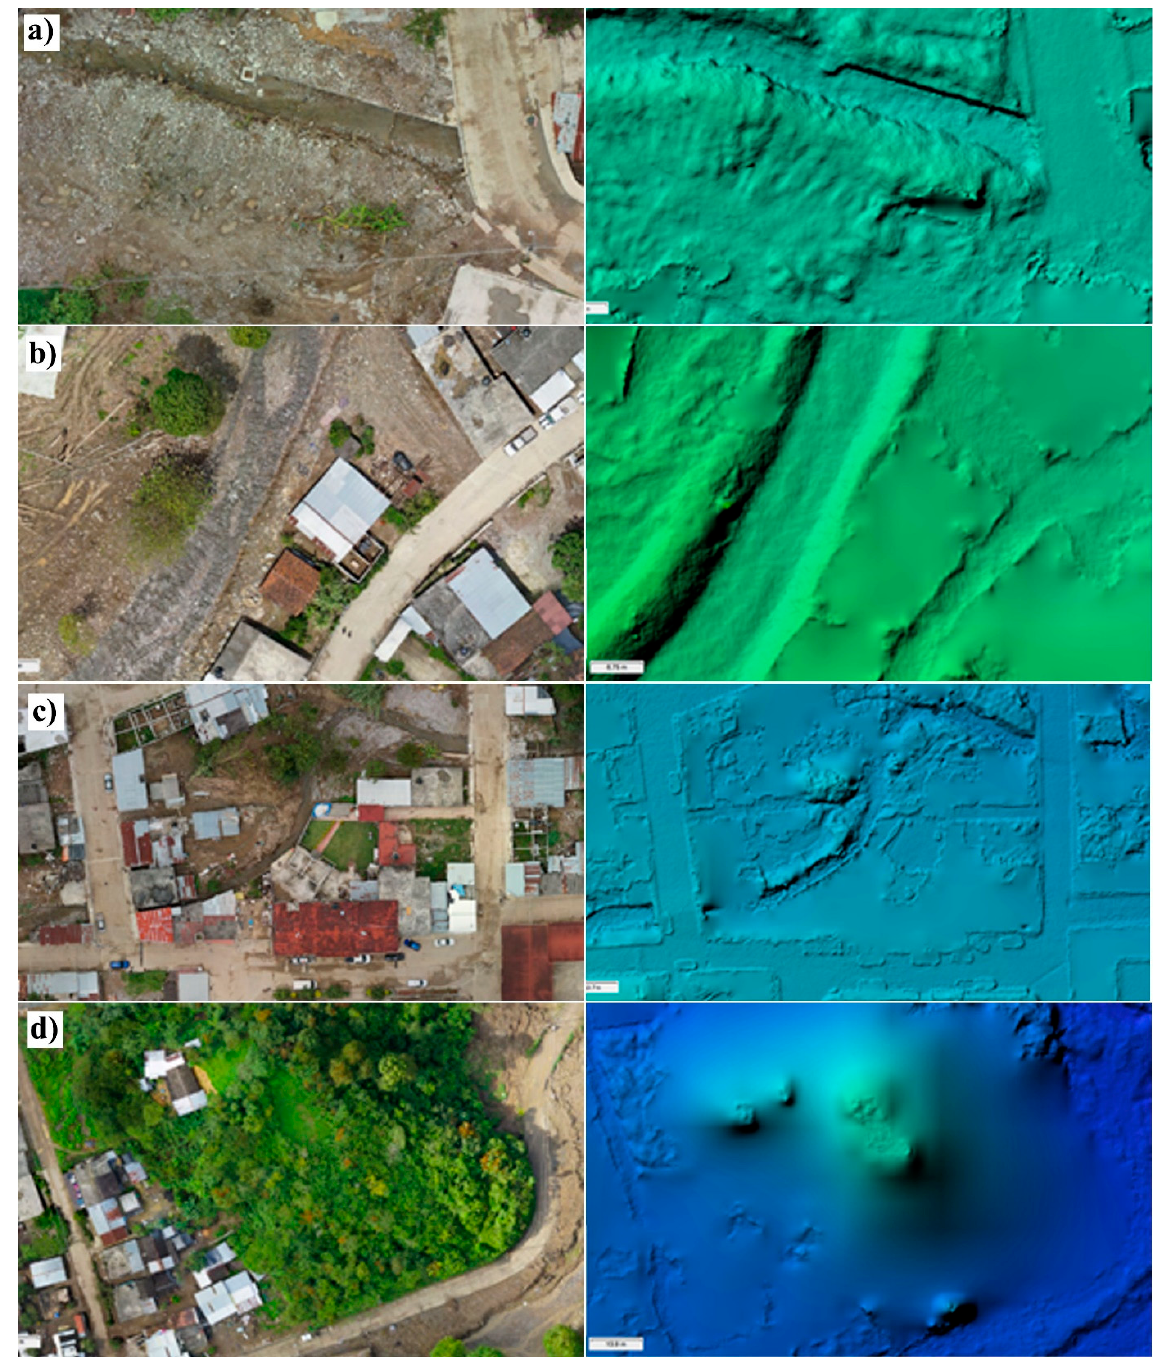
Figure 9. DTM for ( a ) cleared areas, ( b ) isolated vegetation, ( c ) urban areas, and ( d ) dense vegetation and complex mor- phology.